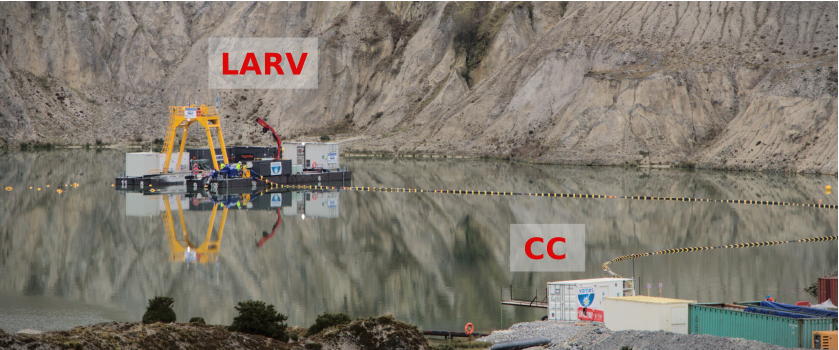
Figure 1. Picture taken during the ¡VAMOS! field trials, showing the launch and recovery vessel (LARV) and the control cabin (CC). At this point in time, the MV was deployed underwater.